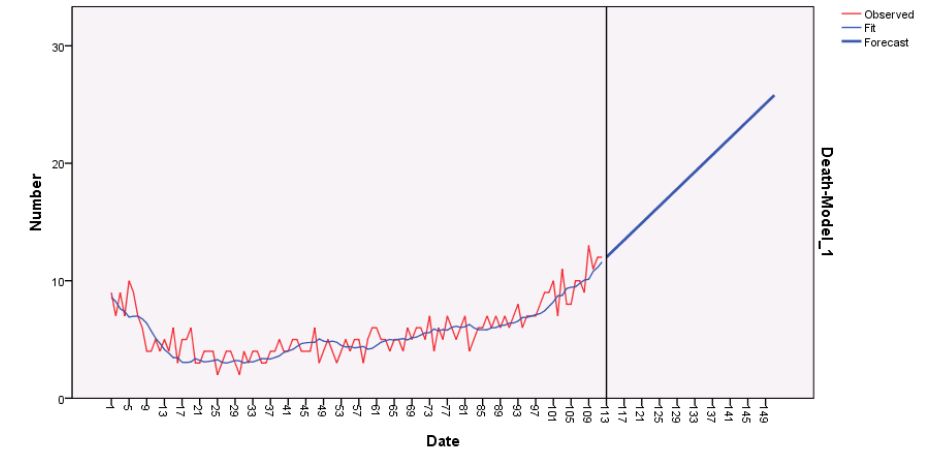
Figure 8. Predicting daily COVID-19 deaths with 95% confidence intervals (CIs) in Saudi Arabia